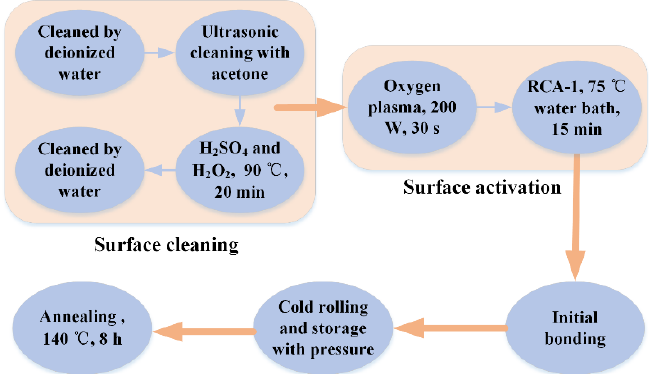
Figure 2. The fabrication process used for direct bonding.